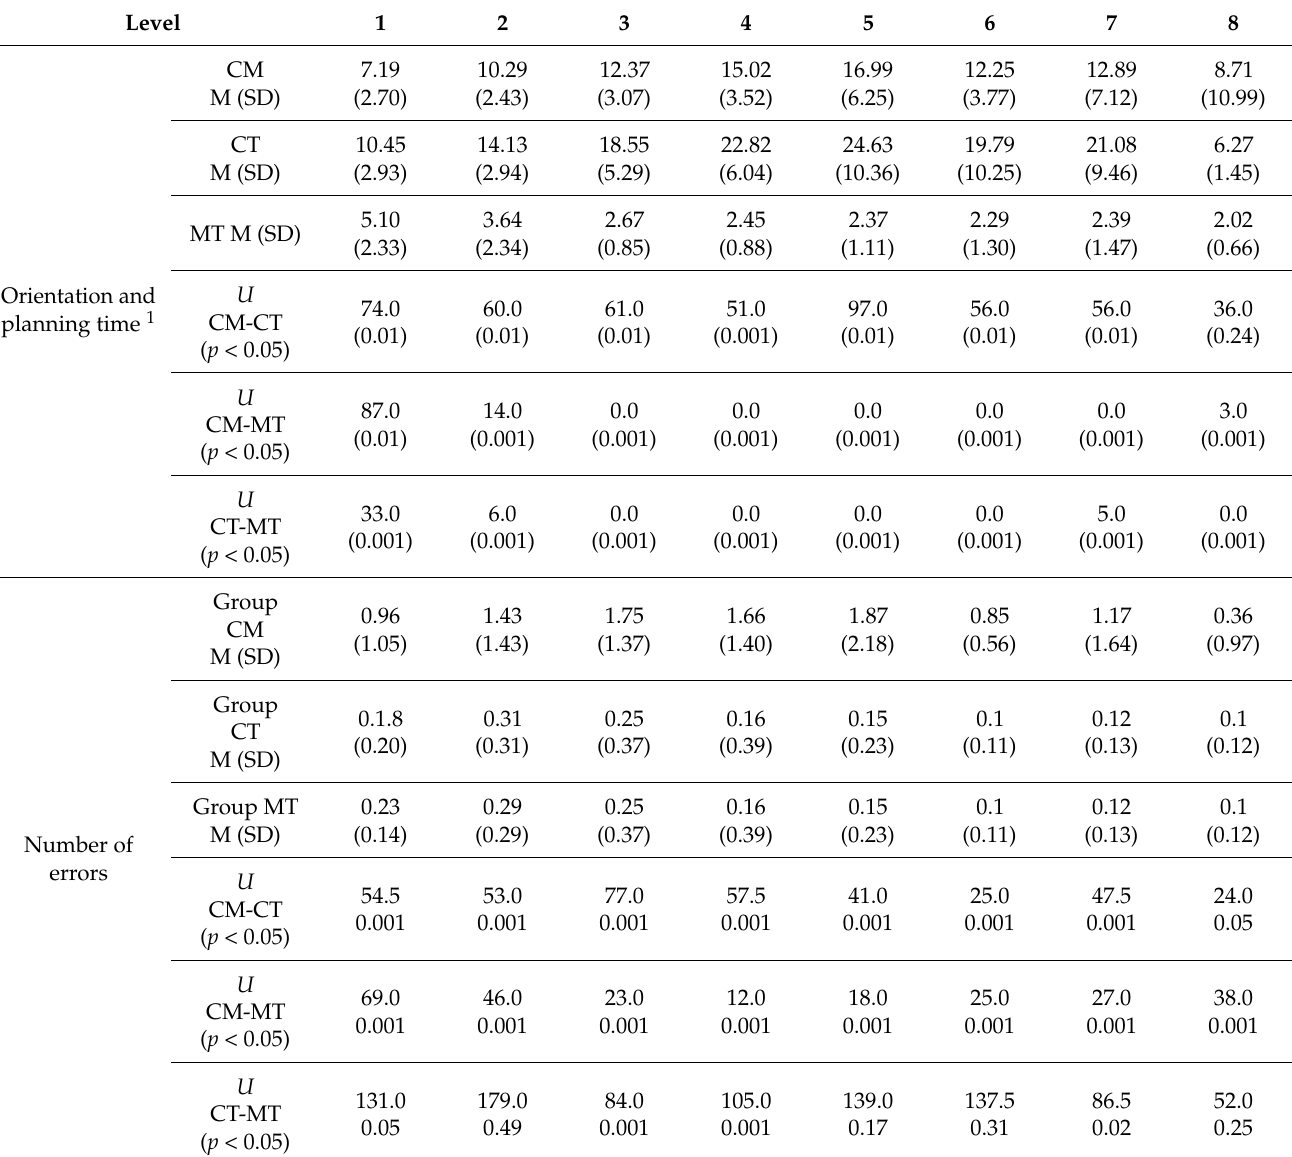
Table 2. Orientation and planning time and the number of errors comparison for all